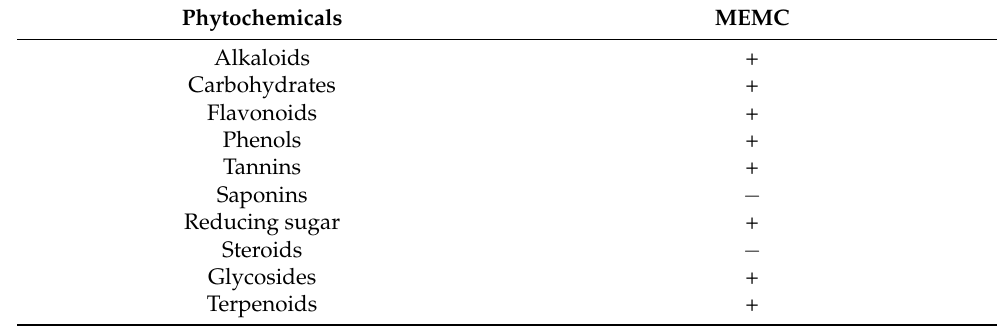
Table 1. Result of preliminary phytochemical analysis of methanol leaf extract of Molineria capitulata